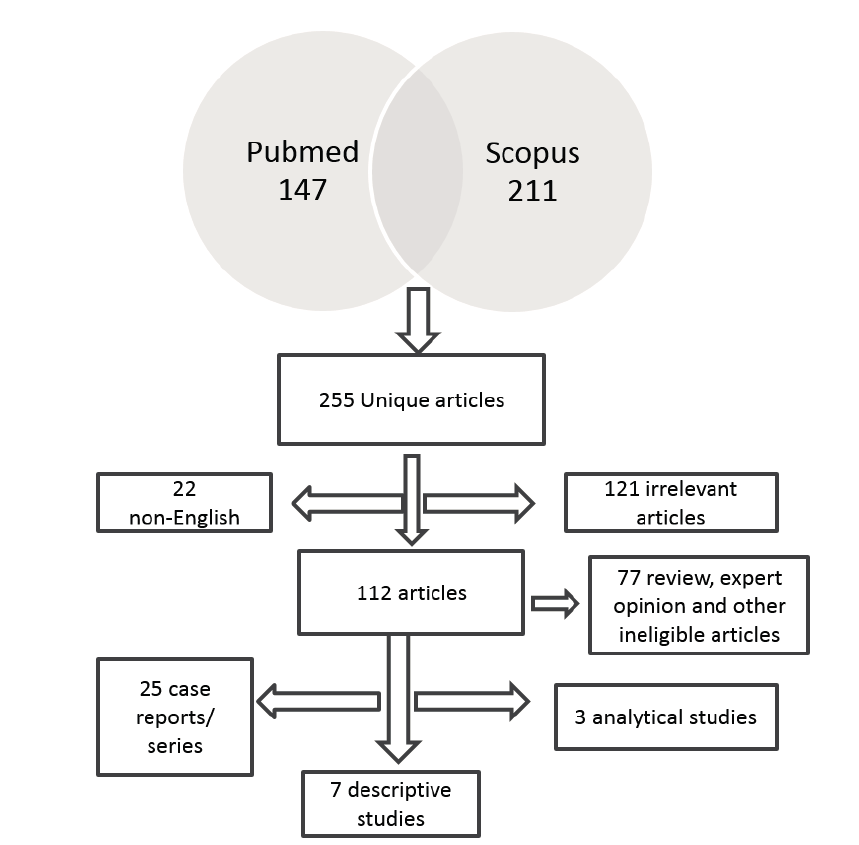
Figure 1. Process of the systematic